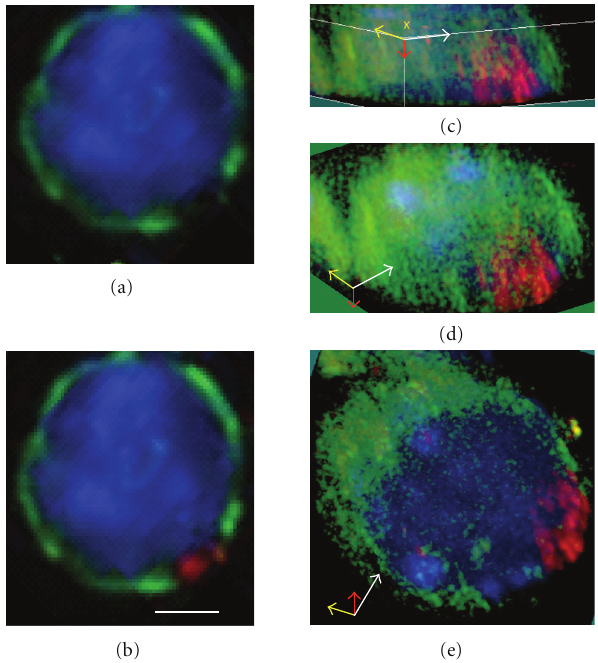
Figure 4: Relationship between XY body, RFP, and nuclear matrix in pachytene spermatocyte. Coimmunofluorescent labeling of lamin B1 (green) with RFP (red). (a), (b) At this cell stage, RFP takes place of lamin B1 along the border of the nucleus (DAPI, blue; bar, 8 μ m). (c)–(e) Data presented as volumes within a 3D-(xyz)-space reconstructed from an RGB image stack. The three dimensions are represented by oriented arrows (x: yellow, y: white, and z: red arrows), considering xyz reference positions taken in